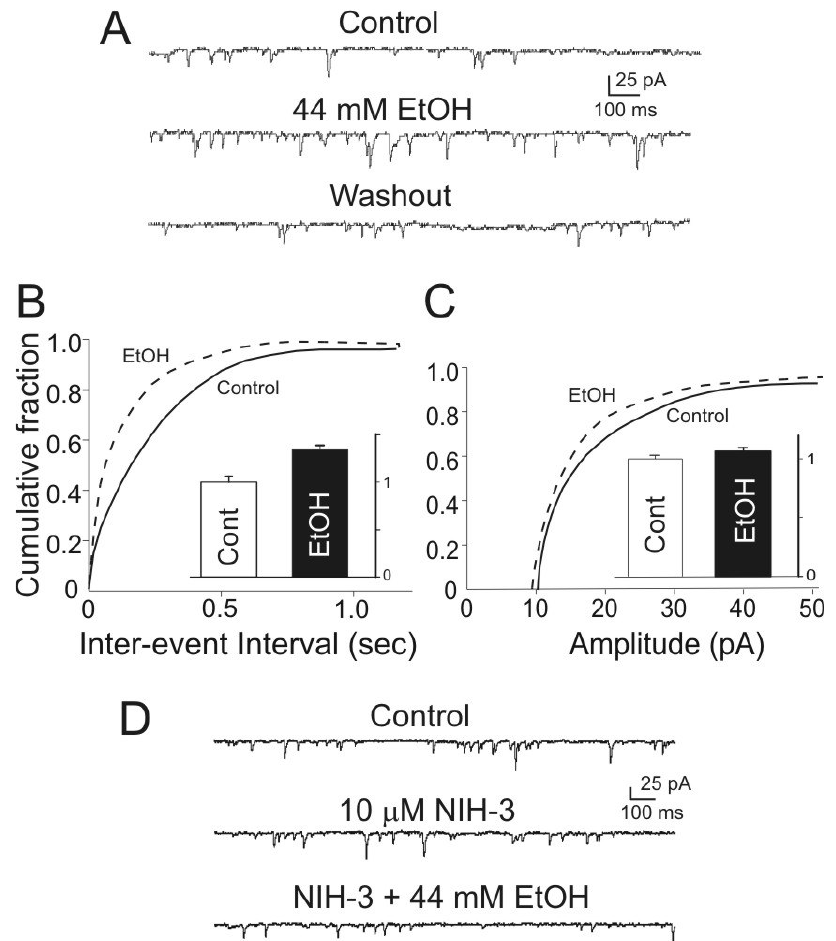
FIGURE 8. Ethanol increases the frequency of spontaneous mIPSCs in CeA neurons from WT mice. (A) Representative current traces recorded from a CeA neuron in the presence of glutamate blockers and TTX. Superfusion of 44 m M ethanol increases the frequency, but has little effect on the amplitude, of mIPSCs, with recovery on washout. Number of recorded events: Control, 14; ethanol, 31; washout, 17. (B) Cumulative frequency histogram of mIPSCs from a representative CeA neuron showing a shift to the left with ethanol, indicating a short inter-event interval (higher frequencies) during the application of 44 m M ethanol. (C) Cumulative amplitude histogram from the same CeA neuron showing a small, but insignificant ( p = 0.32), decrease in the distribution of mIPSC amplitudes. Inset graphs in B and C are pooled data from six CeA neurons showing that mean mIPSC frequency is significantly increased ( p = 0.027), but mean amplitude is only increased insignificantly ( p = 0.56) by ethanol. (D) Current traces from another CeA neuron of a WT mouse. Superfusion of the CRF 1 antagonist NIH-3 (10 µ M ) alone has little effect on mIPSCs, but blocks the ethanol enhancement of IPSC frequency in this neuron. Number of recorded events: Control, 22; NIH-3, 18; washout,